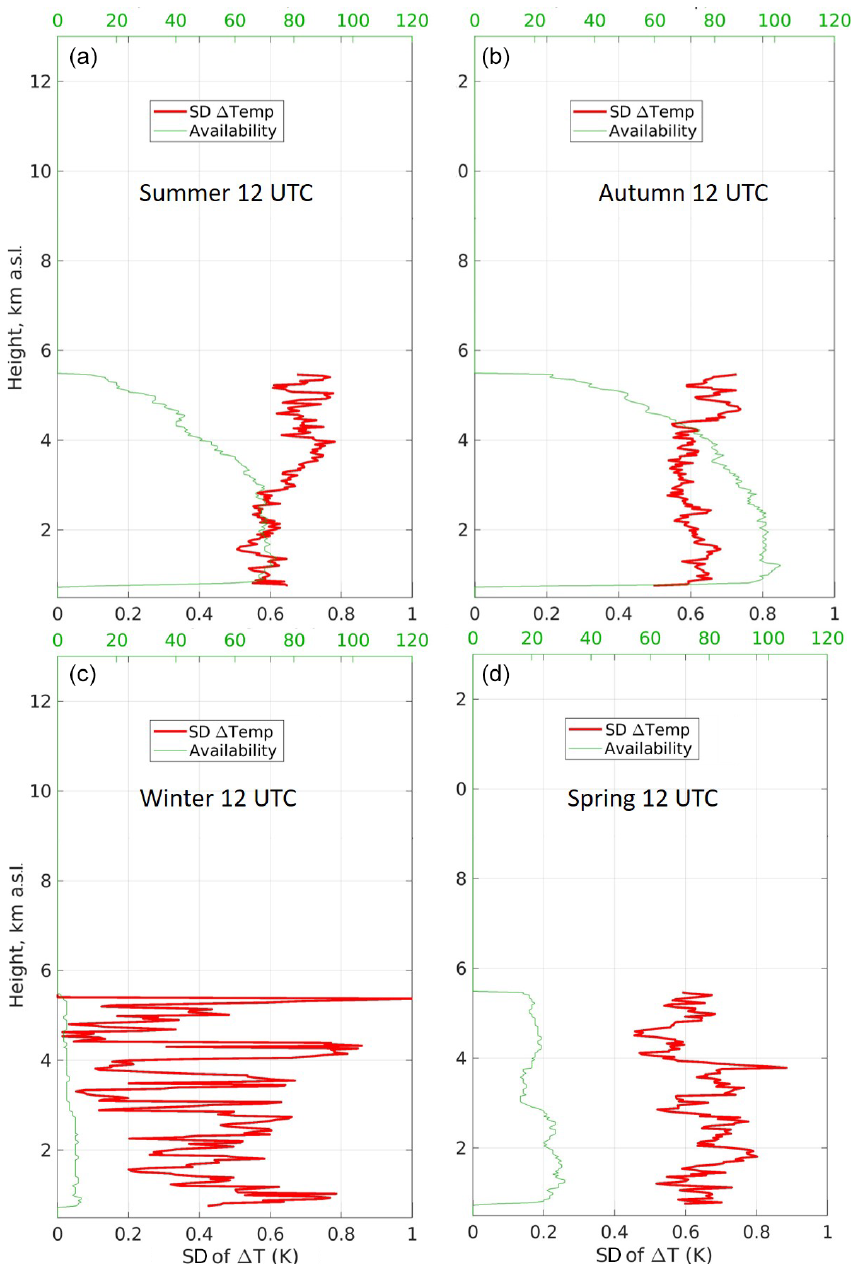
Figure 14. Seasonal daytime standard deviation (SD) of (cid:49)T over the period July 2017–December 2018. The vertical profiles of standard deviation (thick red) are calculated over the altitude-decreasing number of (cid:49)T points (thin green). Based on the definition of seasons provided in the text, in clockwise order starting form the upper-left corner, panel (a) shows the summer data, panel (b) shows the autumn data, panel (c) shows the winter data and panel (d) shows the spring